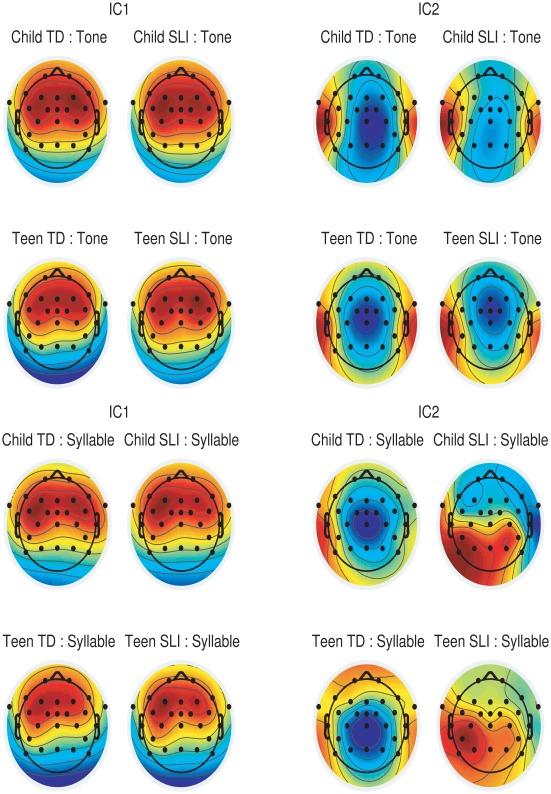
Weightings from electrodes for two independent components corresponding to the vertex and T-complex.